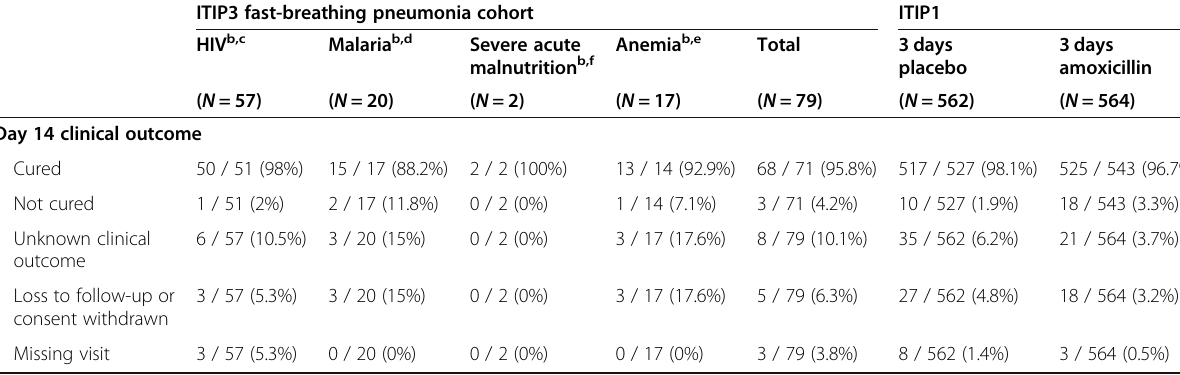
Table 4 ITIP3 fast-breathing pneumonia cohort and ITIP1 clinical cure rates a ITIP3 fast-breathing pneumonia